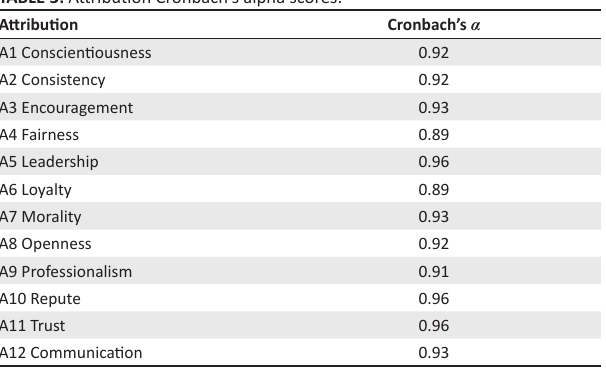
TABLE 3: Attribution Cronbach’s alpha